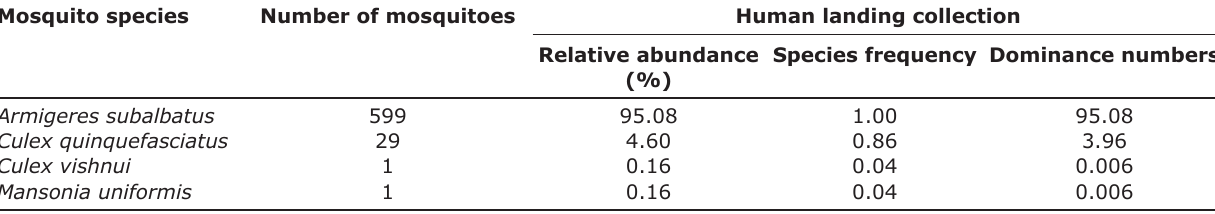
Table-2: The relative abundance, species frequency, and dominance numbers of mosquitoes caught in Lubuk Pauh Village with the human landing collection method. Mosquito species